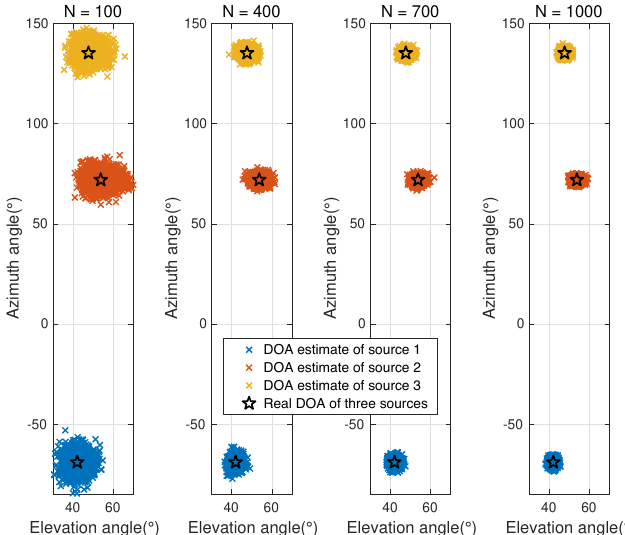
Figure 7. RMSE of DOA estimation versus the number of snapshots from 100 to 1000. ( a ) RMSE of the elevation angle, ( b ) RMSE of the azimuth angle.